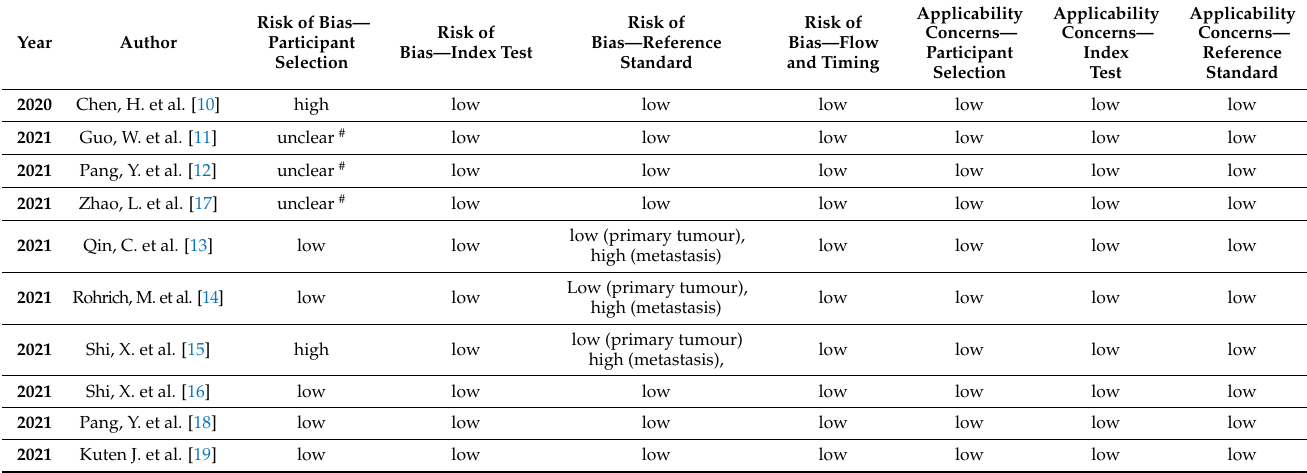
Table 2. QUADAS-2 analysis—subdomain scores (high/low/unclear) per study.